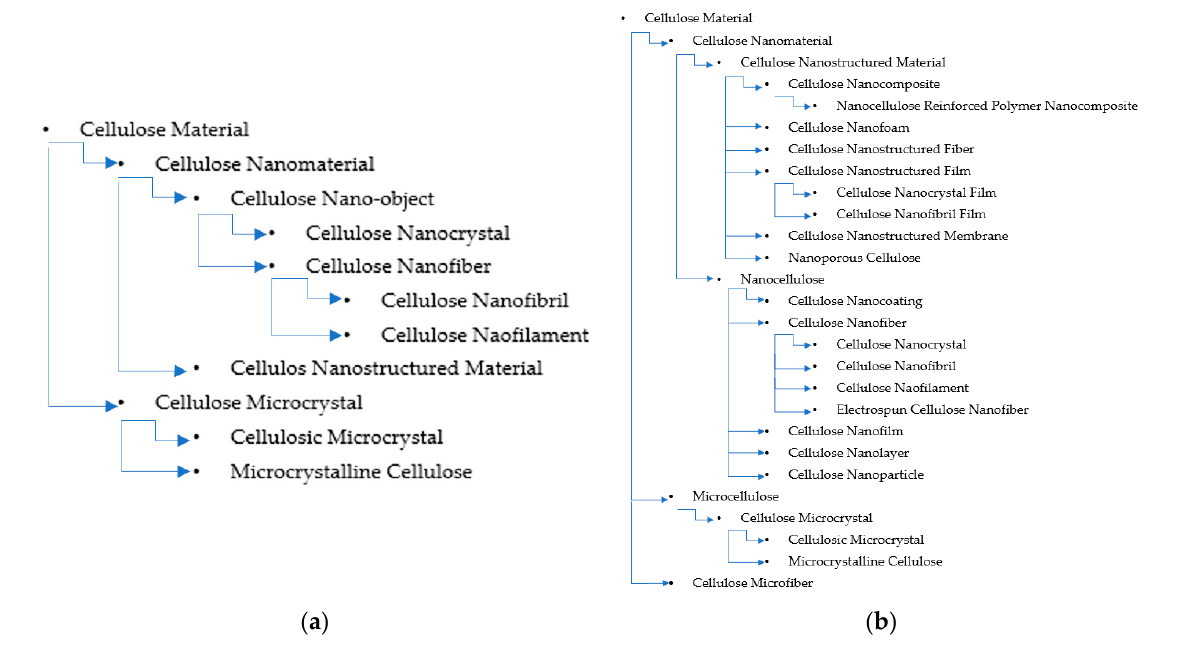
Figure 3. Cellulose material taxonomies ( a ) classification by ISO/TS 20477-2017 and ( b ) modified classification used in this review.